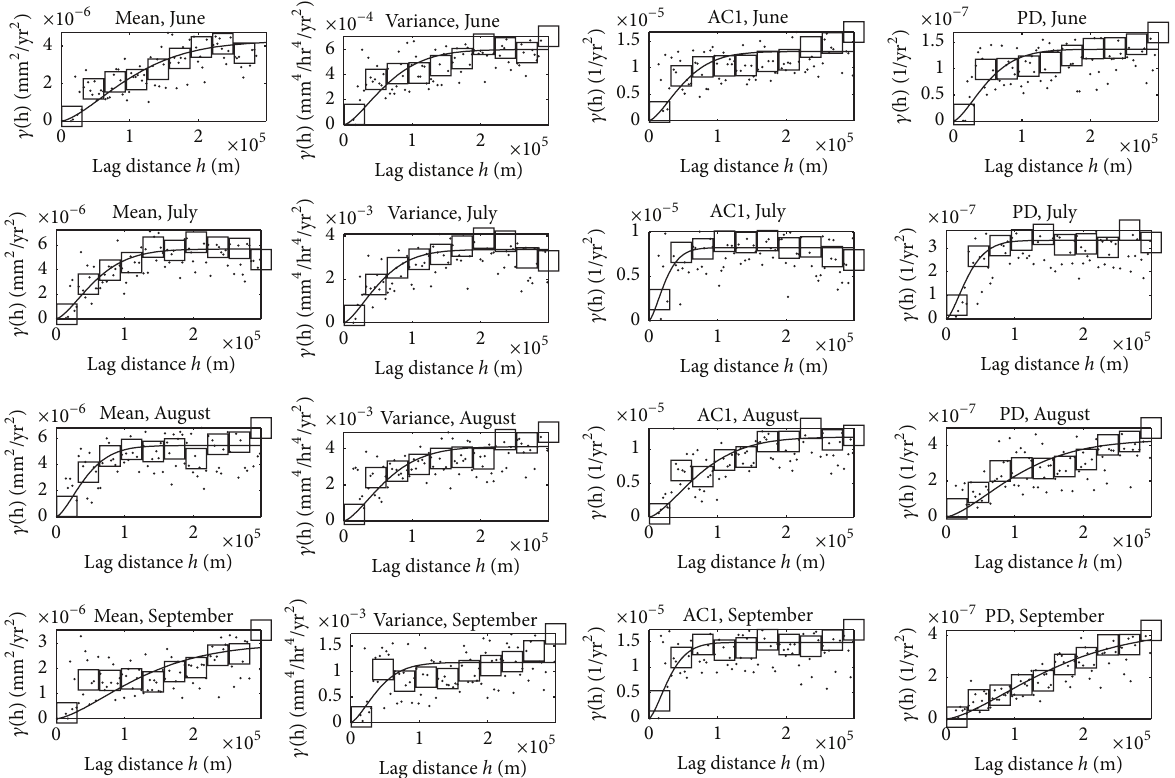
Figure 12: The sample variogram (black dots), the moving averages of the sample variogram (black squares), and the model variogram (black solid line) of the linear trend of the precipitation statistics of June, July, August, and September.